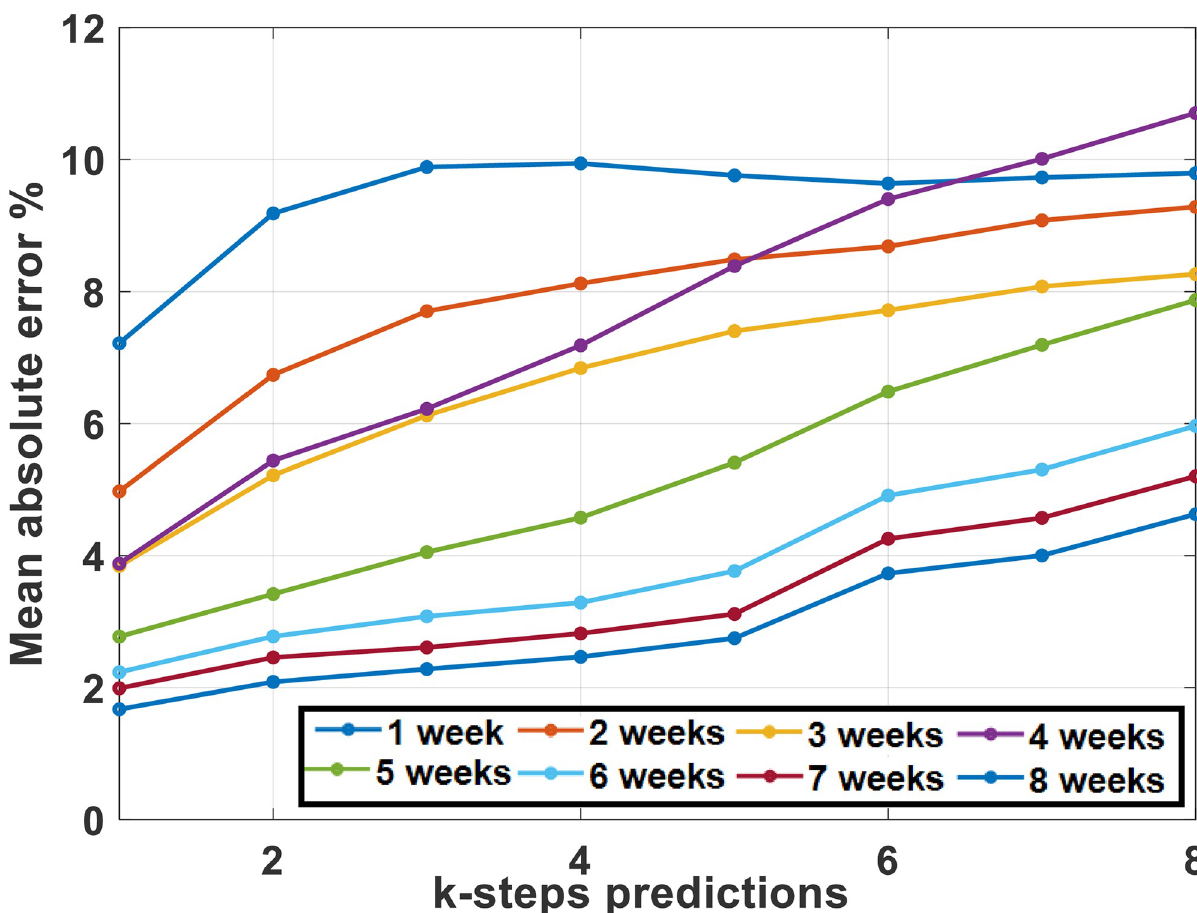
Fig 6. Mean absolute percentage error while predicting productivity ( LOC w ) for different lags (1–8 weeks).